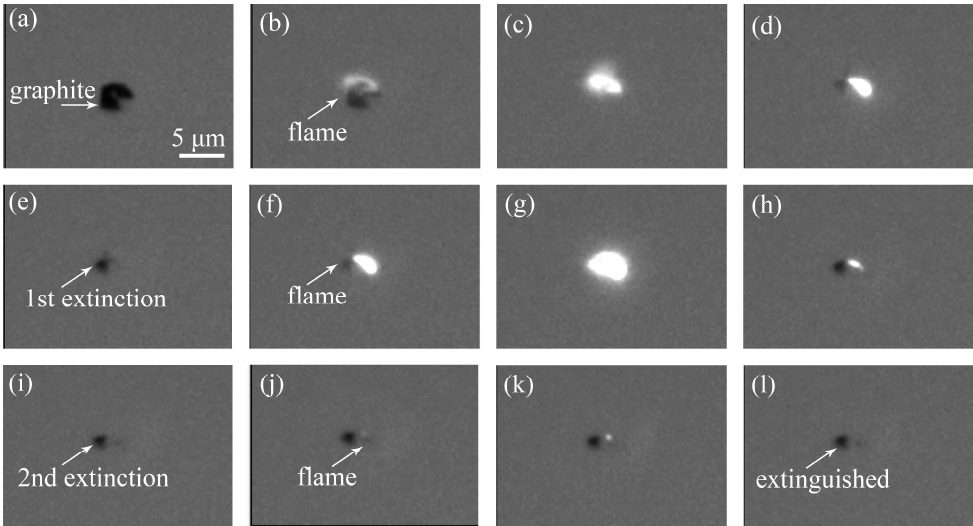
Figure 11. A burning sequence and time history of repetitive extinction and reignition of a graphite particle, ( a ) 0 ms; ( b ) 6 ms; ( c ) 12 ms; ( d ) 144 ms; ( e ) 156 ms; ( f ) 162 ms; ( g ) 168 ms; ( h ) 198 ms; ( i ) 432 ms; ( j ) 456 ms; ( k ) 492 ms; ( l ) 672 ms.